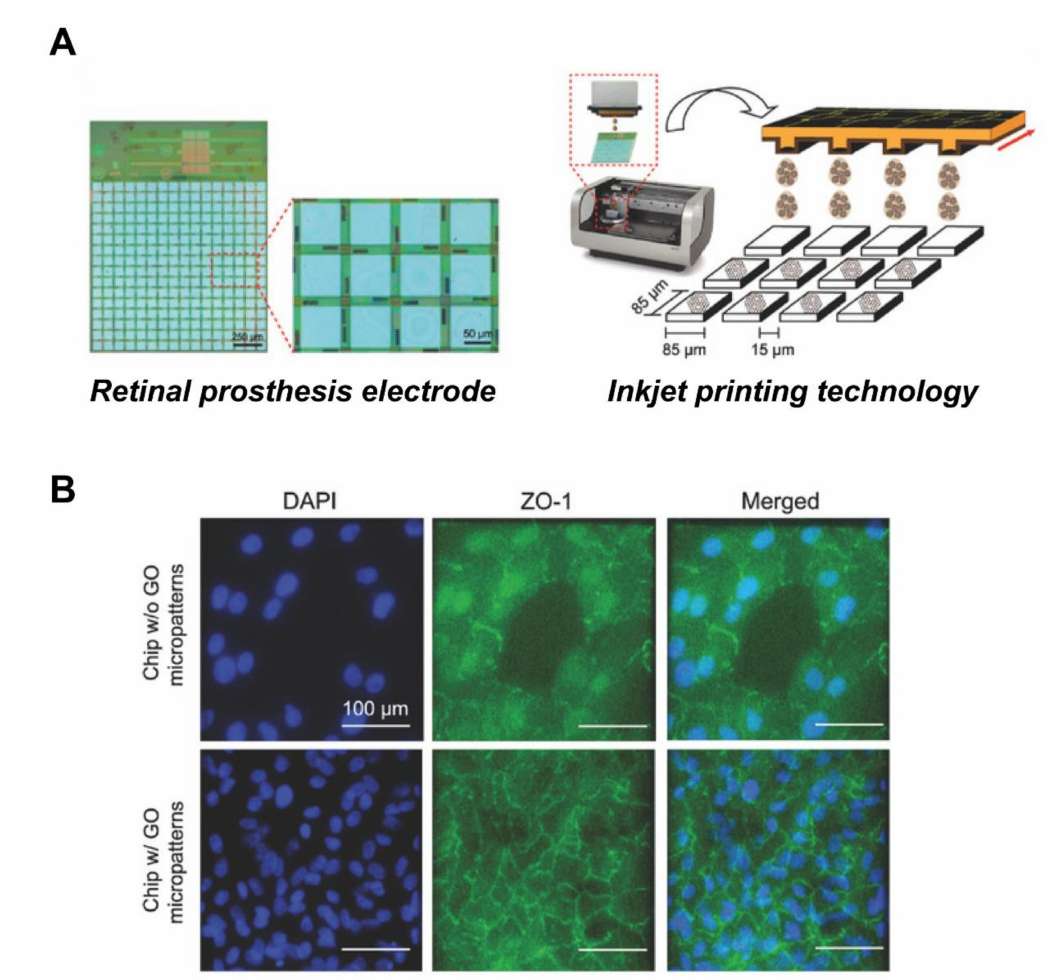
Figure 6. Improved biocompatibility of RPE cells with retinal prosthesis electrode attachment through GO patterns. ( A ) Schematic of the GO micropatterns generated on the electrodes by inkjet-printing technology. ( B ) Fluorescence image of cells stained with tight junction protein marker, ZO-1. The GO-micropatterned interface showed enhanced cell adhesion and barrier function on the retinal prosthesis electrode substrate. Scale bar = 100 µ m. Adapted with permission from Yang et al.